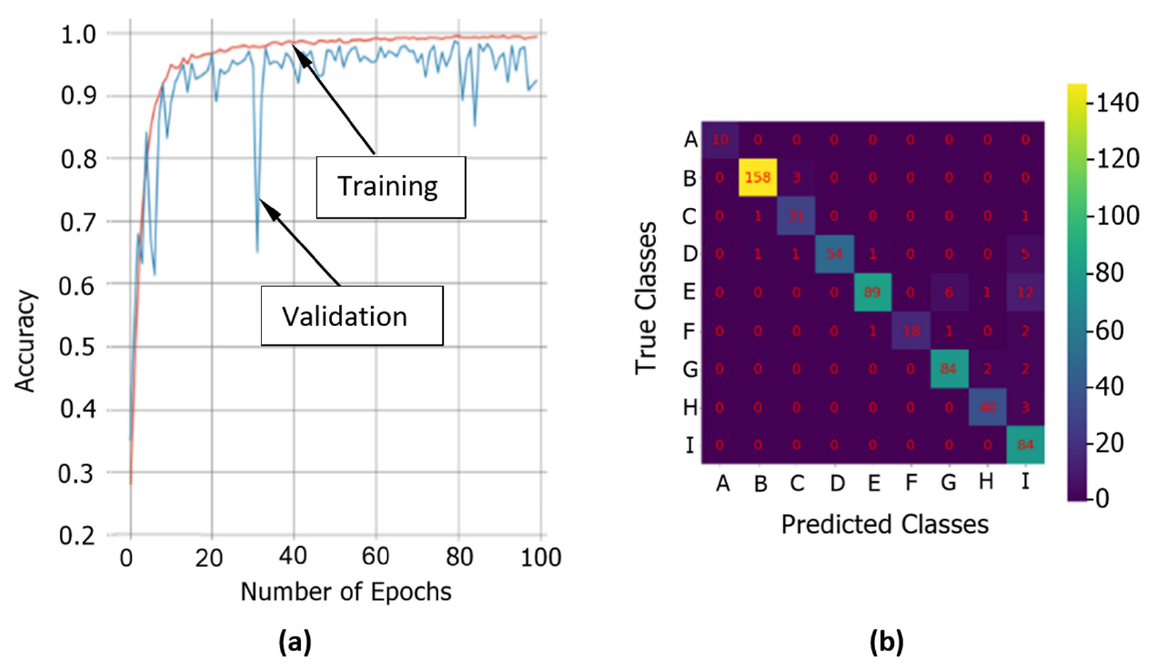
Figure 11. Graphics for InceptionV3 architecture. ( a ) Training and validation accuracy ( b ) Confusion matrix for Test set. Apple variety legend: (A) Blanquina, (B) Carrió, (C) Florina, (D) Fuentes, (E) Prieta, (F) Raxao, (G) Reineta Encarnada, (H) Reineta Pinta, (I) Reineta Roja del Canadá.